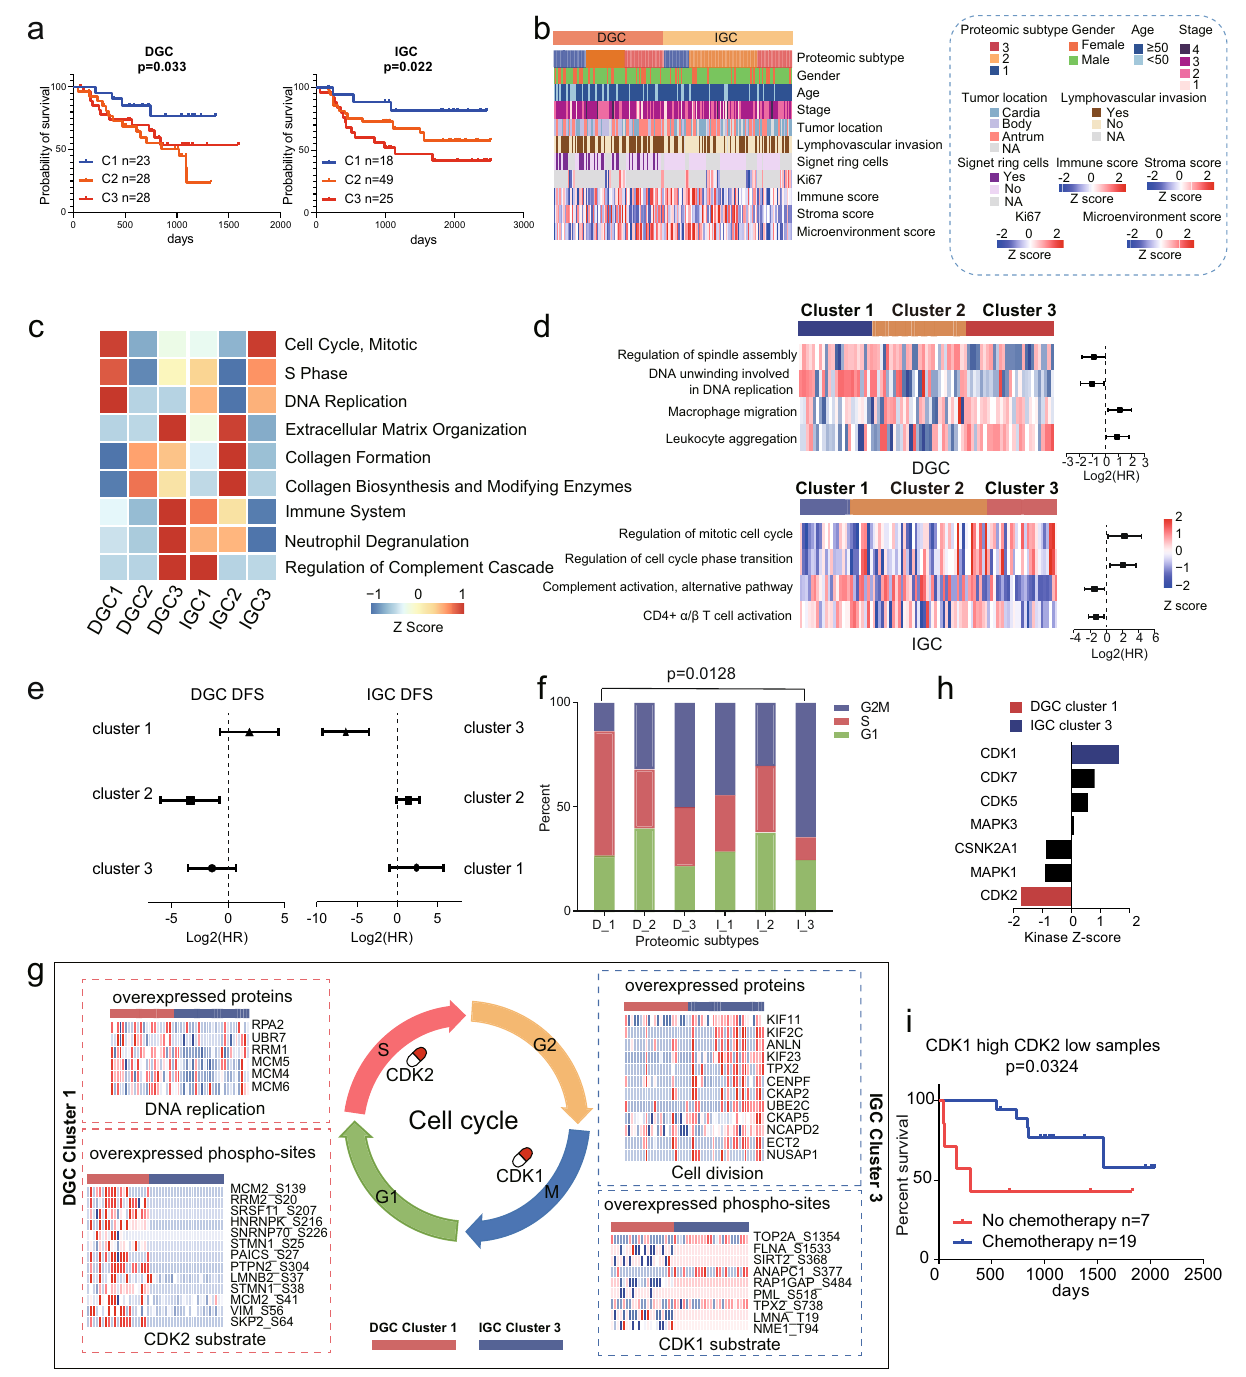
Fig. 4 | Proteomic subtyping of GC and associations with clinical outcomes. a The association of proteomic subtypes with clinical outcomes in DGC and IGC. n (DGC cluster 1)=23, n (DGC cluster 2)=28, n (DGC cluster 3)=28, n (IGC cluster 1)=18, n (IGC cluster 2)=49, and n (IGC cluster 3)=25 biologically independent samples. P -valuesarefromLog-ranktest. b ClinicalcharacteristicsannotationinGC proteomic subtypes. c Pathways that signi fi cantly enriched in the proteomic sub- types. d GSEArevealedthecellcycleand immunerelated pathwaysareenrichedin the proteomic subtypes and have opposite prognoses between DGC and IGC. n (DGC)=79 and n (IGC)=92 biologically independent samples. The points and error bars show the median of hazard ratio (HR) and 95% con fi dence interval (CI). e The association of chemotherapy with DFS in each GC proteomic subtypes. Chemotherapy: n (DGCcluster1)=19, n (DGCcluster2)=22, n (DGCcluster3)=22, n (IGC cluster 1)=12, n (IGC cluster 2)=36, and n (IGC cluster 3)=20 biologically independent samples. No chemotherapy: n (DGC cluster 1)=4, n (DGC cluster